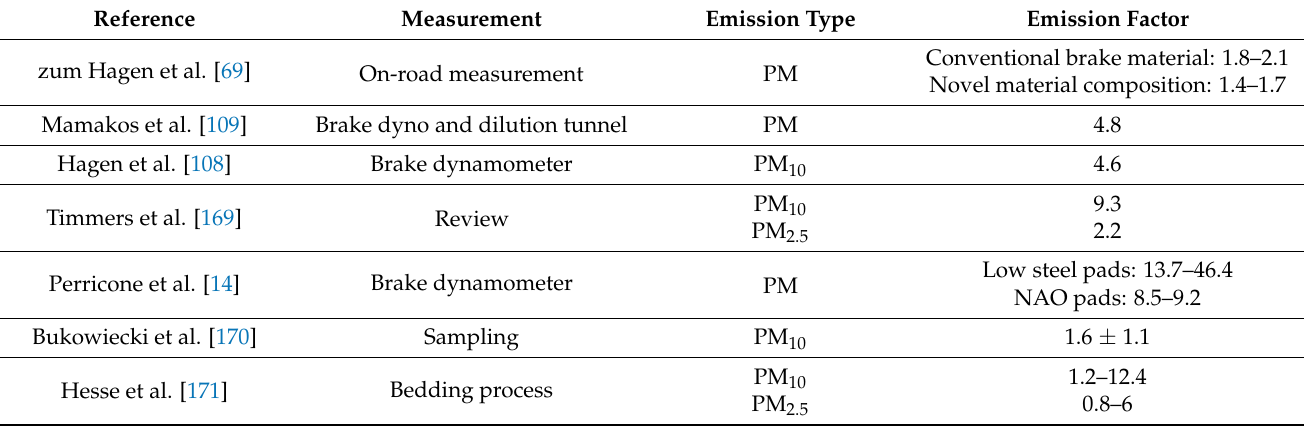
Table 3. Emission factors of brake wear reported in the literature for LDVs and passenger cars (mgkm − 1 brake − 1 ).